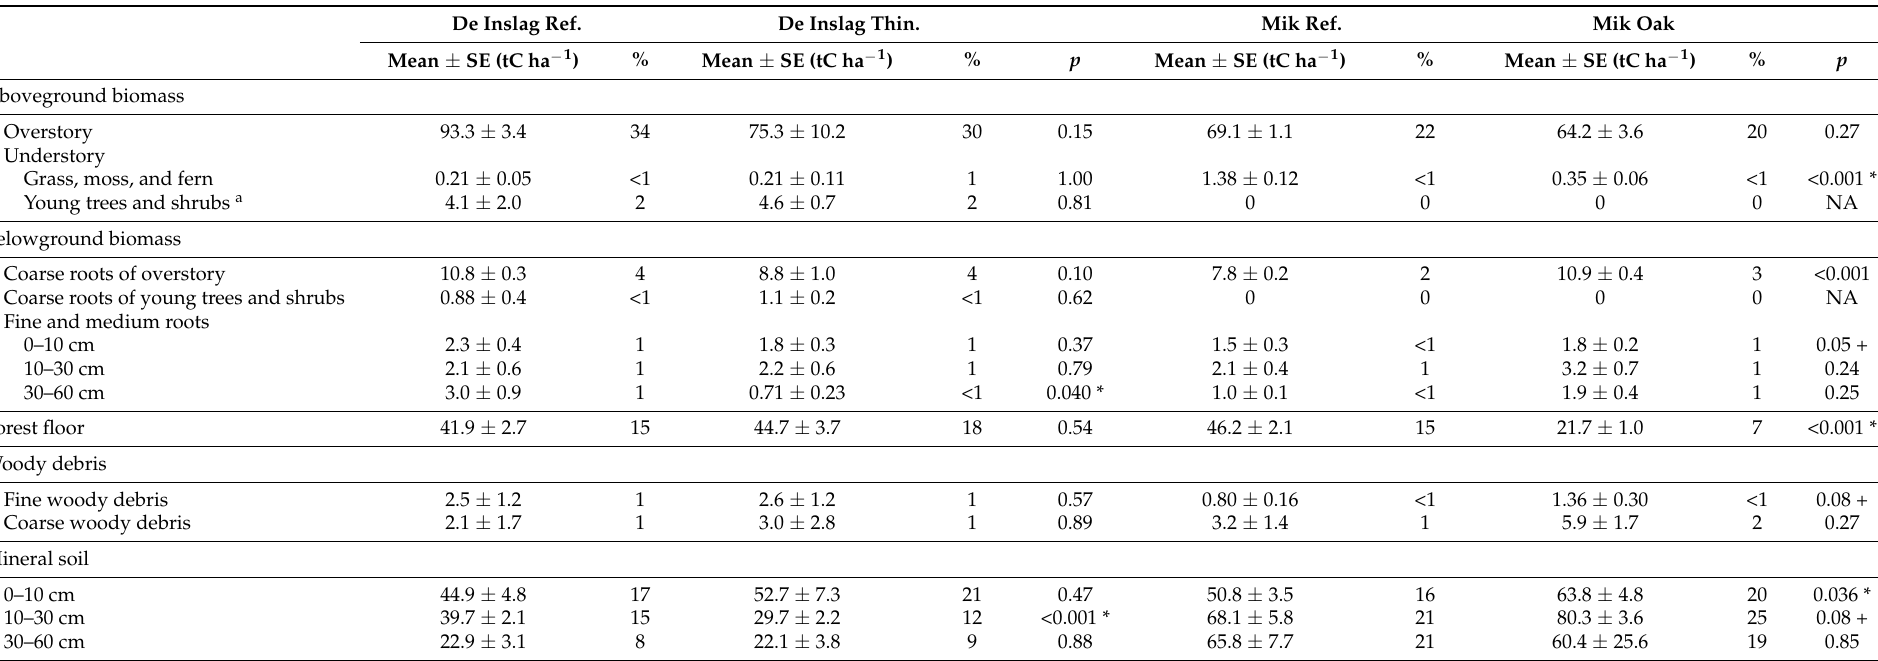
Table 2. Overview of the mean values of C stocks (tC ha − 1 ) with standard error (SE; tC ha − 1 ) at the study stands. ‘%’ indicates the percentage relative to the total C storage in the ecosystem for each component. The p-value shows the statistical significance between pairs of stands (De Inslag Ref. vs. De Inslag Thin. and Mik Ref. vs. Mik Thin.); the star (*) indicates when p < 0.05, the plus (+) indicates when 0.05 < p < 0.10. NA indicates not applicable. De Inslag Ref. De Inslag Thin. Mik